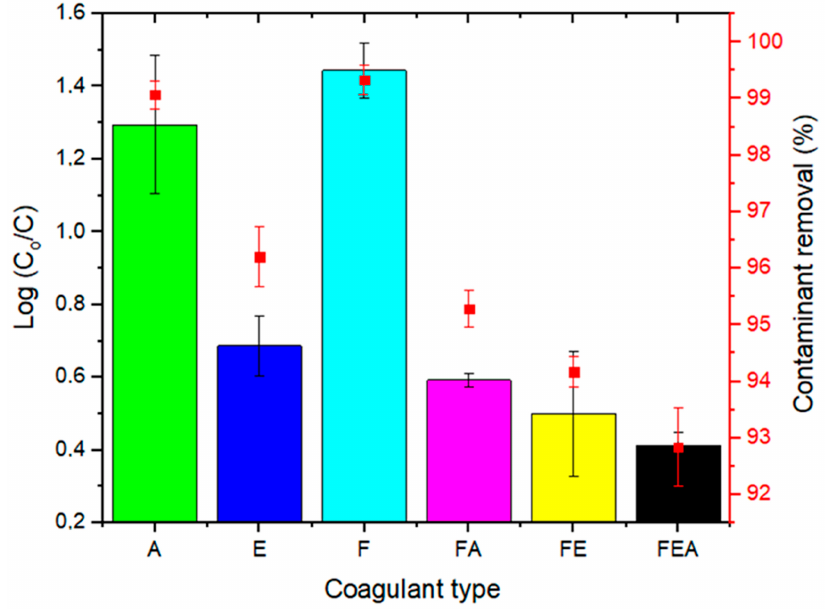
Figure 6. Performance of the coagulant at the optimum dosage (20 mg/L) and settling time (30 min) for the removal of turbidity (%): F > A > E > FE > FA >